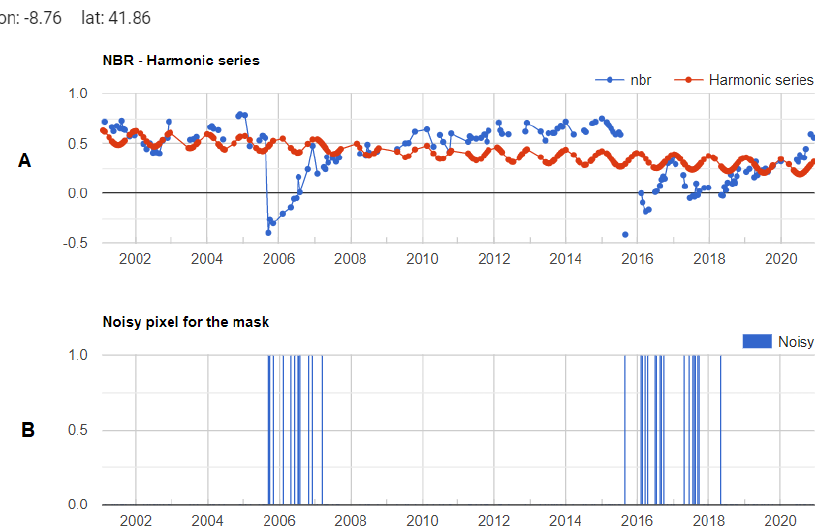
Figure 6. Example of the identification of disturbed areas in a historical series for a single pixel (lat 41.86/lon − 8.76). ( A ) Time series harmonic adjustment of a pixel. The blue line represents the actual NBR values, and the red line represents the adjusted harmonic model based on the NBR values for the analysis period 2001–2020; ( B ) the blue bars represent the pixels (images) of the time series used to construct the mask of possible burnt